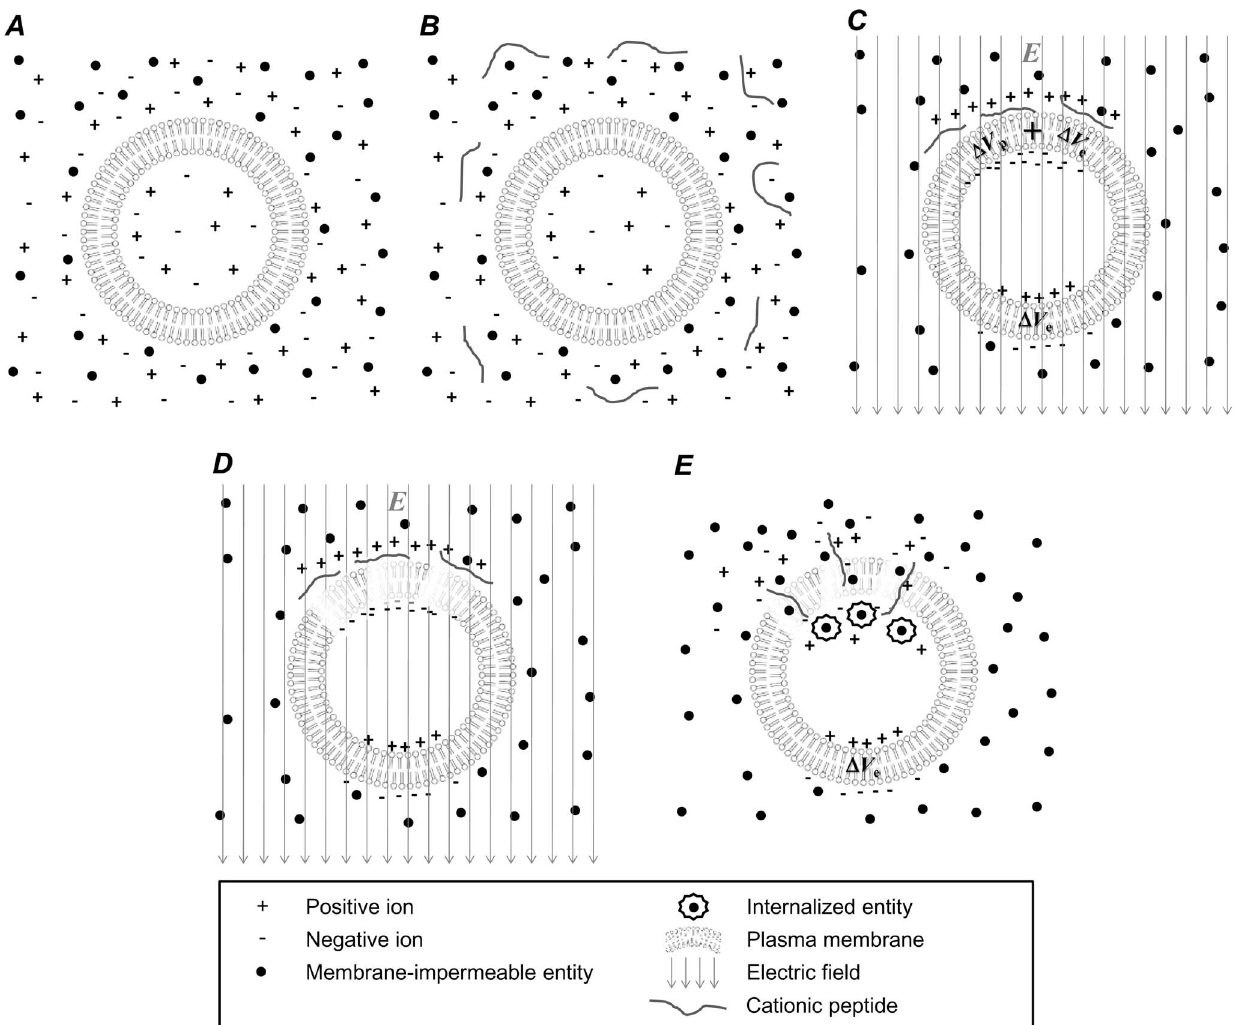
Figure 2. When used in concert with an externally applied PEF, cationic peptides can be used to enhance membrane disruption at lower PEF intensities at the anode-facing cell membrane. When a cell rests in an ionic medium containing membrane impermeable entities ( A ) and cationic peptides are added to that medium ( B ), a PEF can be used to accumulate those cationic peptides about the anode-facing membrane ( C ) where the anode-facing membrane can experience a local increases in electrostatic potential near individual peptides ( V p ) plus enhanced electrostatic potential due to the ion relocation due to the applied field ( V e ). These local enhancements in transmembrane electrostatic potentials can result in anodally preferenced electroporation at lower PEF intensities ( D ) and subsequent internalization of normally membrane-impermeable entities through the anode-facing membrane ( E ).